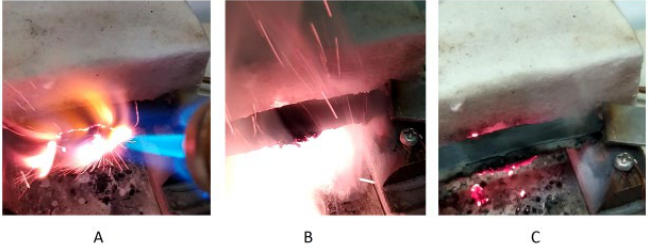
Figure 4. Snapshots of CB monolith subjected to ignition in presence of gunpowder: ignition with flame ( A ); self-sustained combustion ( B ); extinction ( C ). Similar tests were carried out with both BWC bulk and monolith covered by gun- powder. The recorded signal of EMF is shown in Figure 5A, where the negative peak fol- lowing gunpowder ignition achieved an absolute value of around 1750 μV at time 210 s.